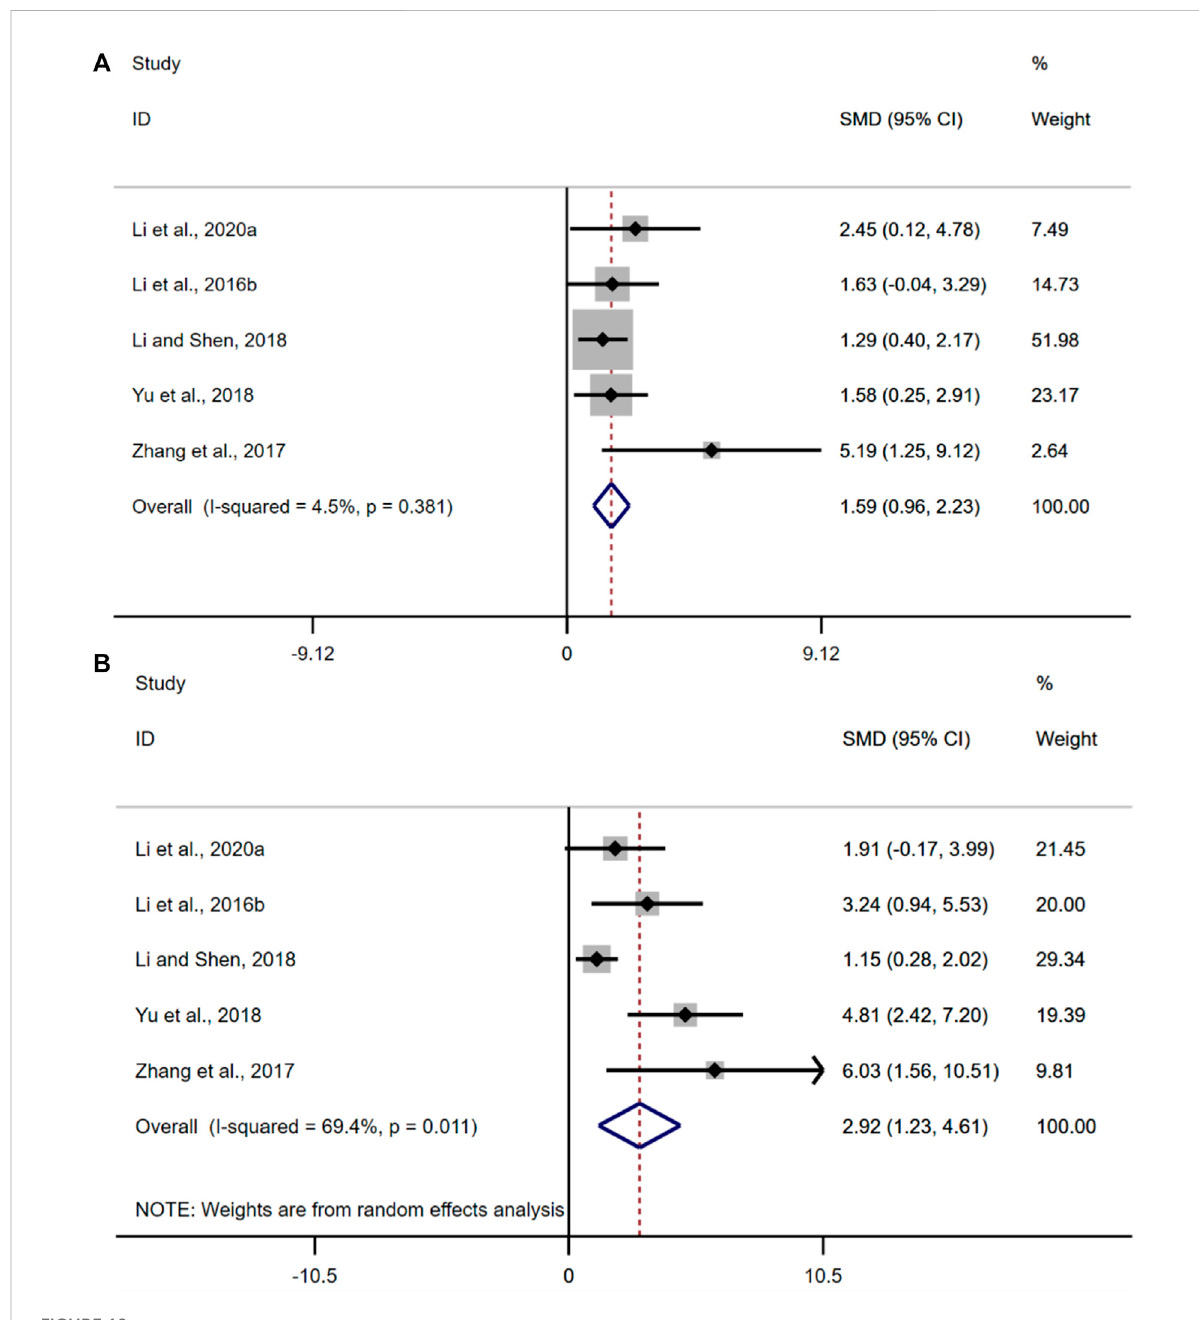
FIGURE 10 Forest plot: effect of berberine on (A) ZO-1, and (B) occludin.